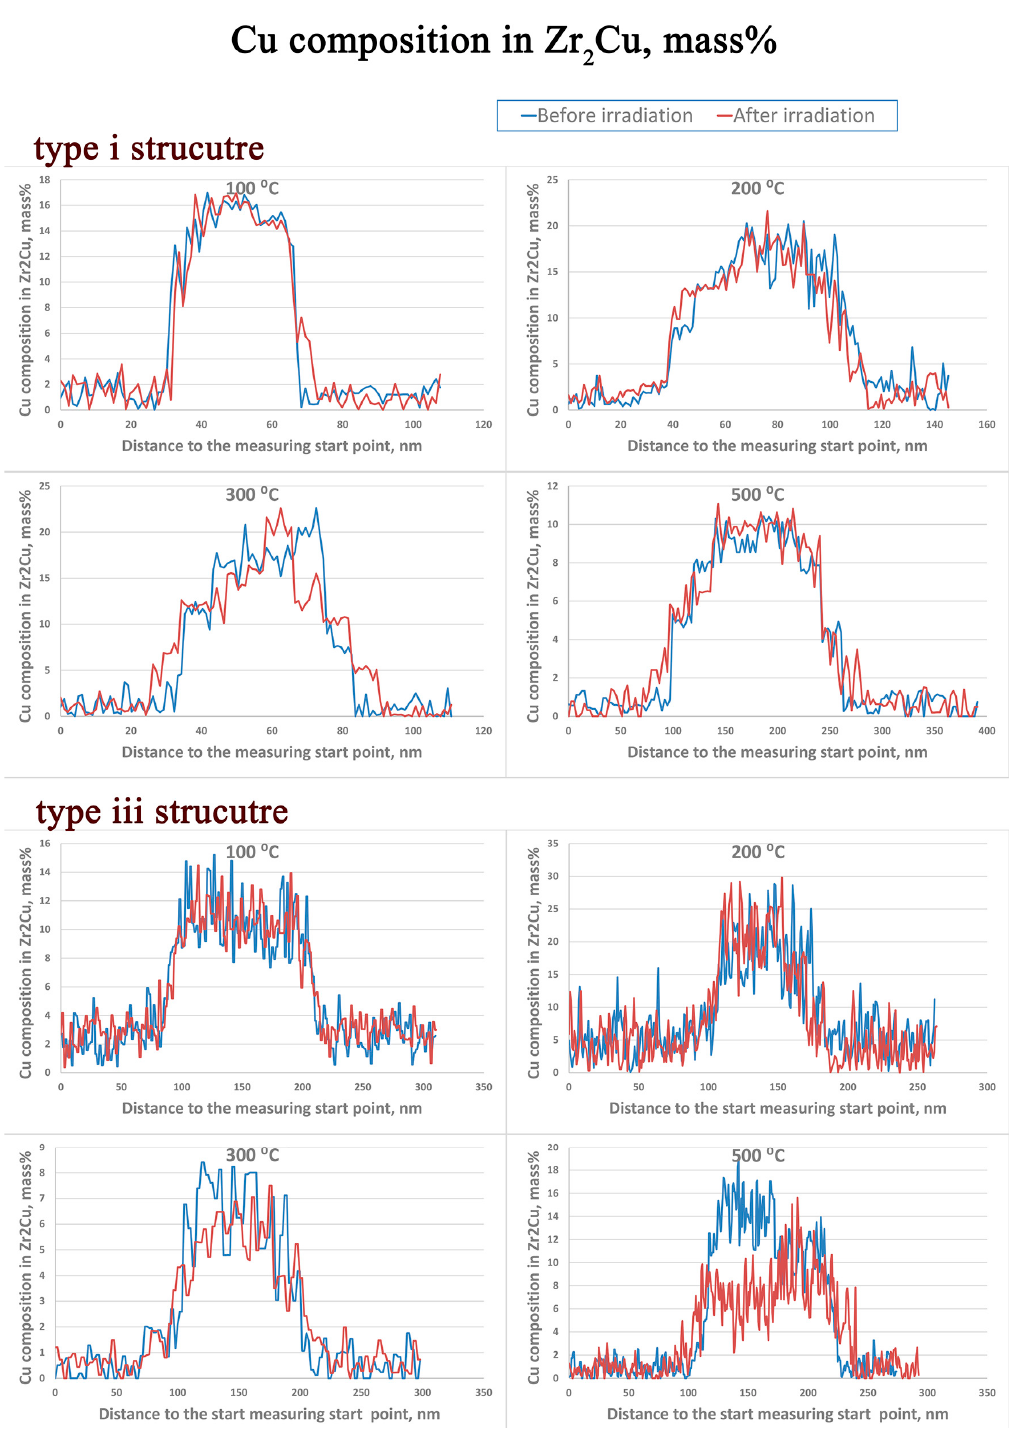
Figure 8. The concentration change of Cu in Zr 2 Cu precipitates in type i and iii structures before and after irradiation at 100 ◦ C, 200 ◦ C, 300 ◦ C, and 500 ◦